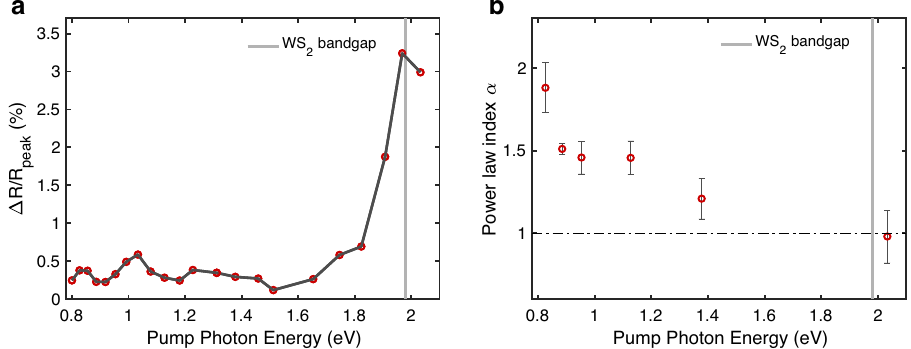
Fig. 5 Excitation photon energy dependence of the hot-carrier transfer. a Pump photon energy dependence of Δ R = R max at constant incident fl uence excitation ~30 μ J/cm 2 measured on WS 2 /graphene HS; b Pump photon energy dependence of the fi tting parameter α , index of the power-law fi tting function. Error bars represent the 95% con fi dence bounds of the fi tted power-law